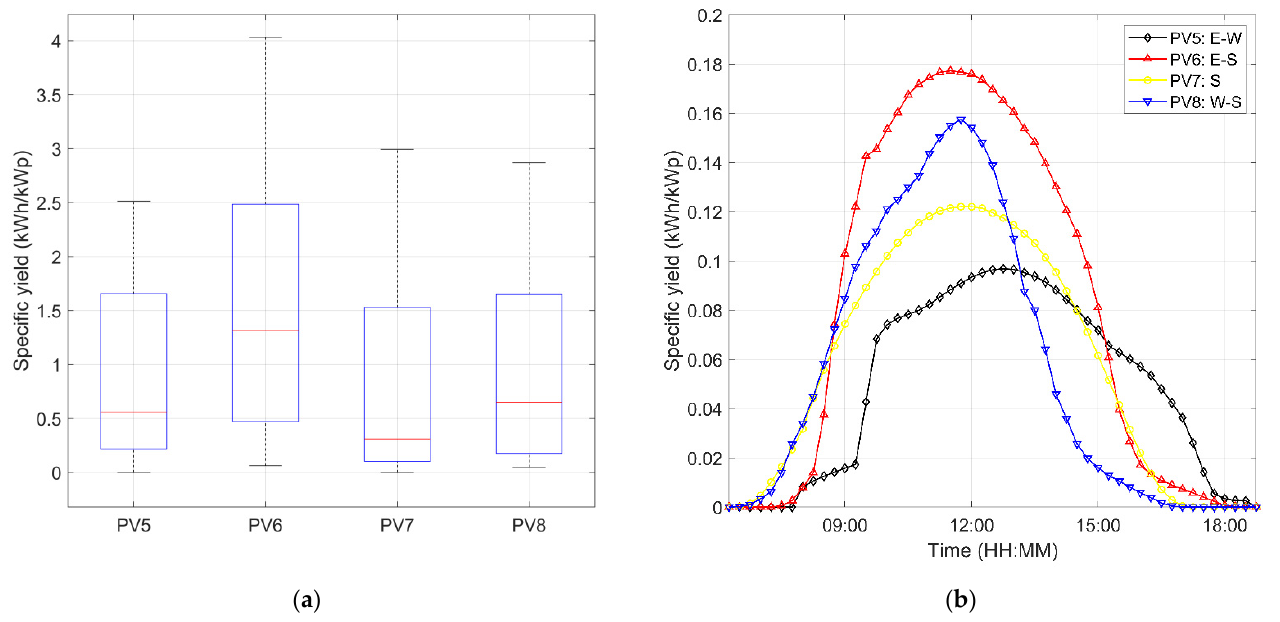
Figure 5. ( a ) Daily specific yields of the PV5–PV8 systems obtained in February 2021 and ( b ) daily energy profiles of the PV5–PV8 systems measured under a clear sky on 2 February 2021.